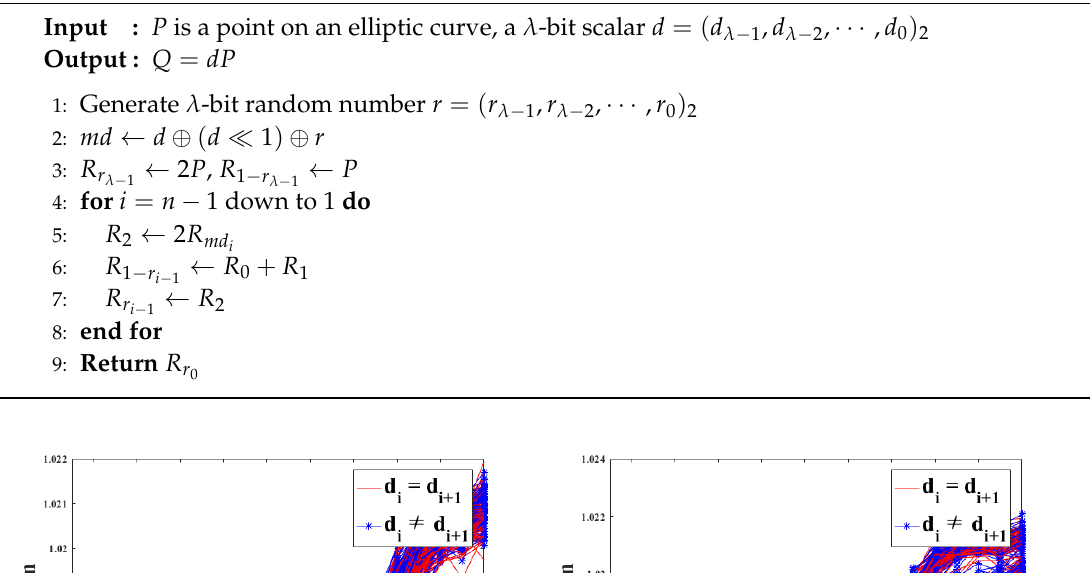
Algorithm 2: ECC Scalar Multiplication (Masking with random bit)